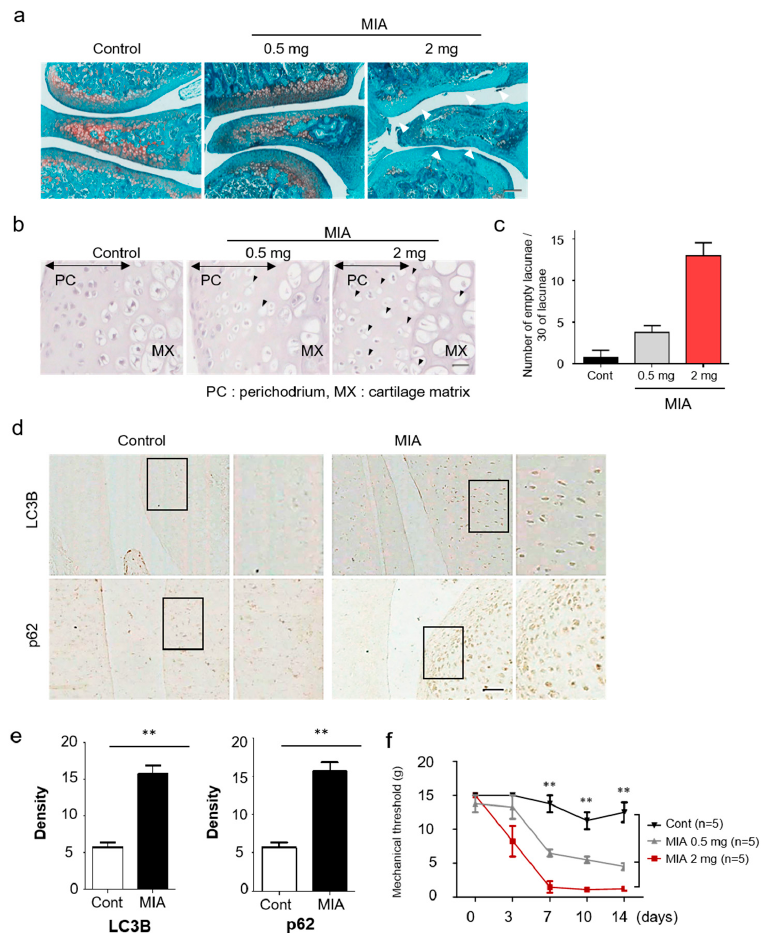
Figure 1. Increased autophagy and cartilage damage in a monosodium iodoacetate (MIA)-induced osteoarthritis model. ( a ) A histologic feature of knee joints in the MIA-induced osteoarthritis (OA) model. At 3 days after injection, the joint sections were stained with Safranin-O / Fast Green. ( b ) Representative hematoxylin stained sections of knee joints on dependent of MIA dose after 3 days. Black arrowheads indicate the chondrocytic cell death in damaged cartilage areas. ( c ) Quantitative analysis for empty lacunae due to chondrocytes death. ( d ) Expression of LC3B and p62 in knee cartilage was measured by immunohistochemistry. ( e ) The density of each protein was quantified with Image J. ( f ) Rats were subjected to behavioral tests using von Frey filaments to evaluate the effect of MIA-induced OA. Scale bar = 50 µm.